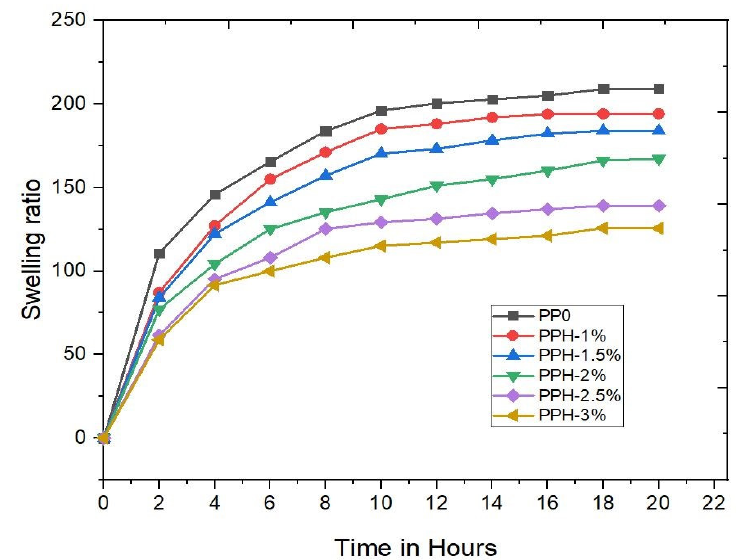
Figure 3. Swelling behaviors of PVA/PVP/HA hydrogels.